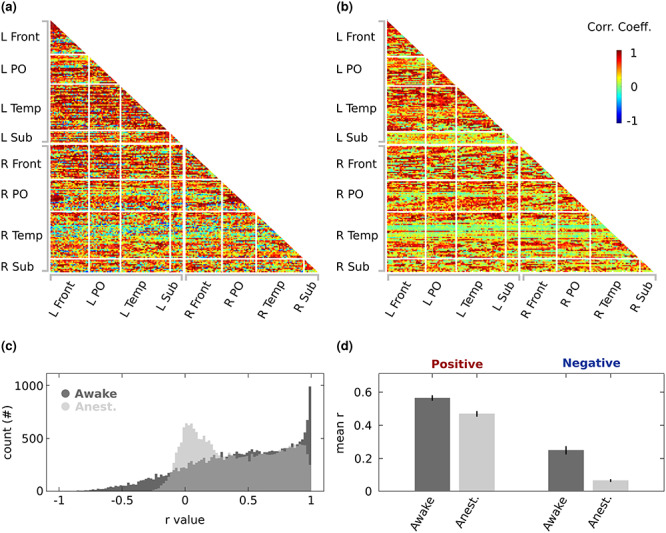
Functional connectivity profiles for the awake and anesthetized experiments. Temporal correlations between the fMRI signal in the ROIs listed in Supplementary Material S5, grouped in 4 broad anatomical subdivisions of the brain. Functional connectivity profile for the (a) awake (Monkey T: n = 60 runs, Monkey D: n = 60 runs) and (b) anesthetized (Monkey T: n = 30 runs, Monkey D: n = 30 runs) fMRI runs. The strength of the connections between ROIs are represented by color-coded correlation coefficients (r-values). (c) Comparison of the distribution of r-values for the awake and anesthetized scans. (d) Mean r-values for the positive and negative correlations. Error bars denote the bootstrapped 95% confidence intervals. L = left, R = right, Front = Frontal Cortex, PO = Parietal-Occipital Cortex, Temp = Temporal Cortex, Sub = Subcortical.